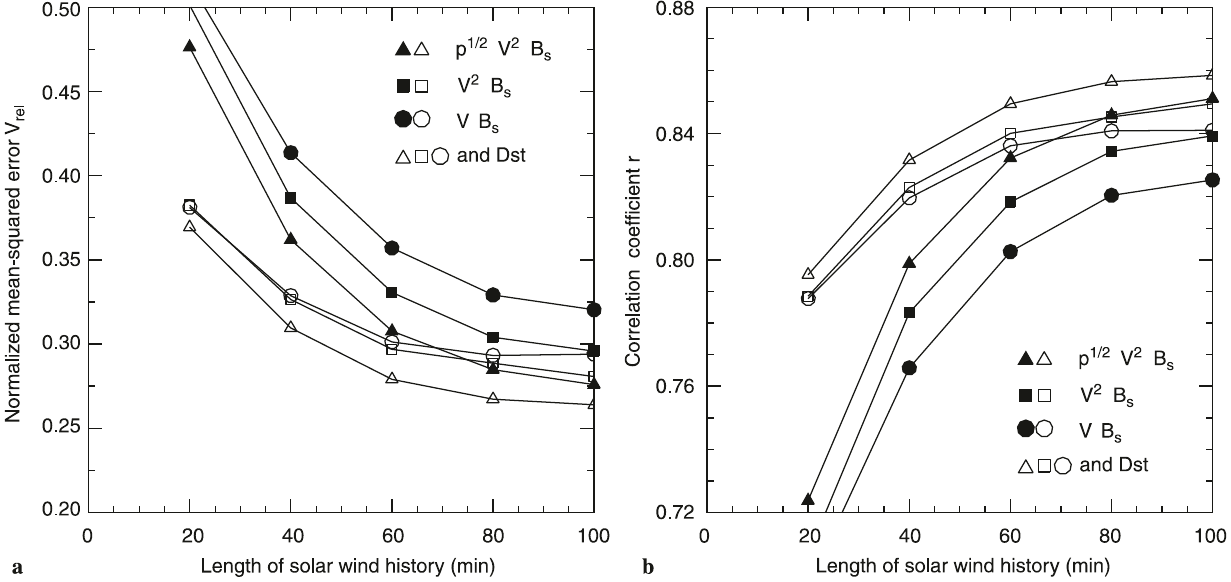
improved by Dst for all the coupling functions tested here. The largest improvements occur when much information on the solar- wind conditions are missing. Some information is always lost when measured solar-wind variables are combined into